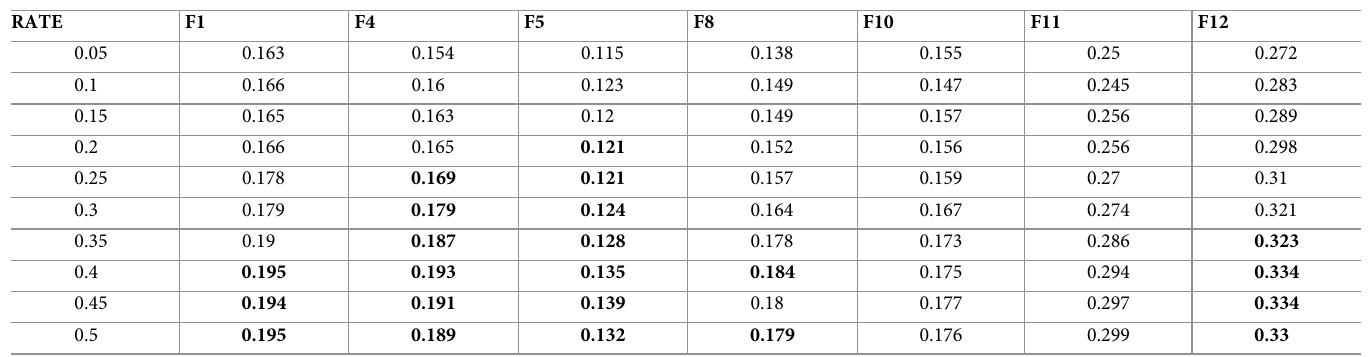
Table 17. RMSE of MICE by feature.